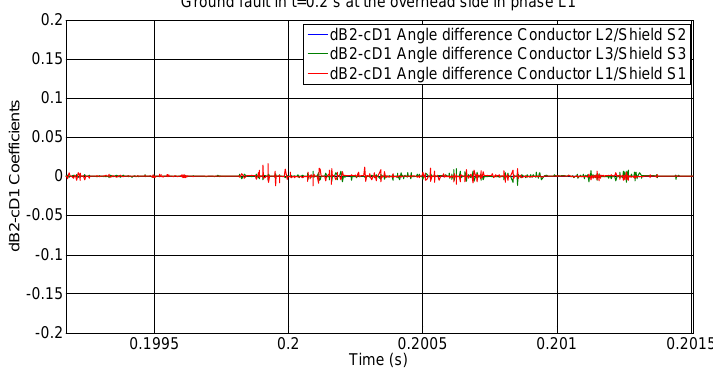
Figure 12. Wavelet dB2-1-cD1 coefficients of the angular difference signals with ground fault in phase L1 at the overhead side 12 km from the transition.